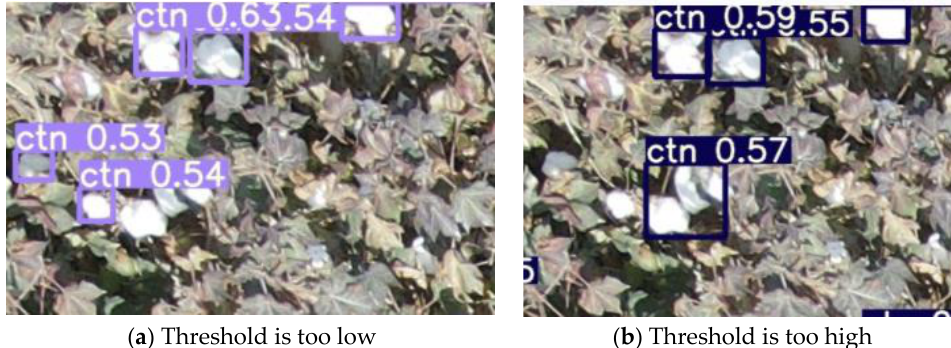
Figure 9. Impact of Threshold on Recognition Results.